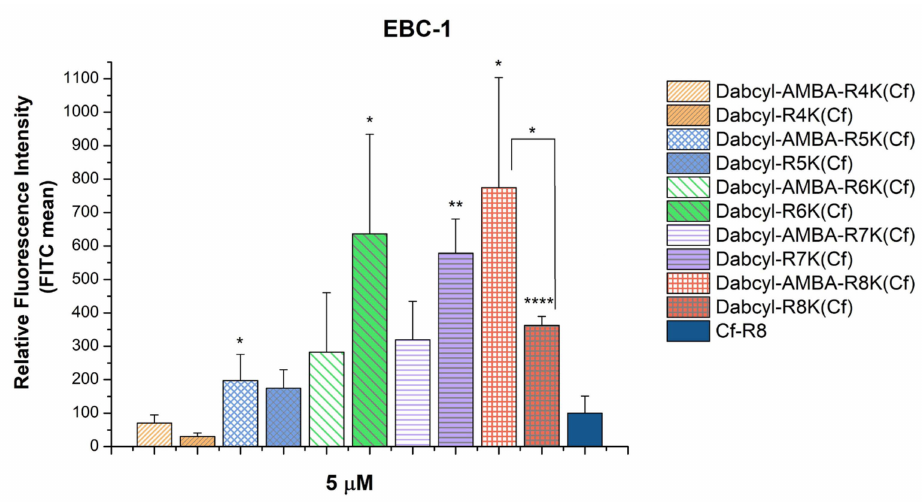
Figure 2. Comparing the effect of Dabcyl and the Dabcyl-AMBA group on the internalization of short oligoarginines into EBC-1 cells. The cells were treated with the peptides at a concentration of 5 µ M at 37 ◦ C for 90 min. After trypsinization the fluorescence intensity of the cells was studied using flow cytometry. The fluorescence intensities were normalized to the fluorescence intensity of cells that were treated with Cf-Arg 8 (100%). Any significant difference between the control Cf-Arg 8 and peptides with the same amount of arginine was measured using the Student’s t test. The asterisks show a significant difference between the control octaarginine and the two modified octaarginines (* p < 0.05, ** p < 0.01, **** p <